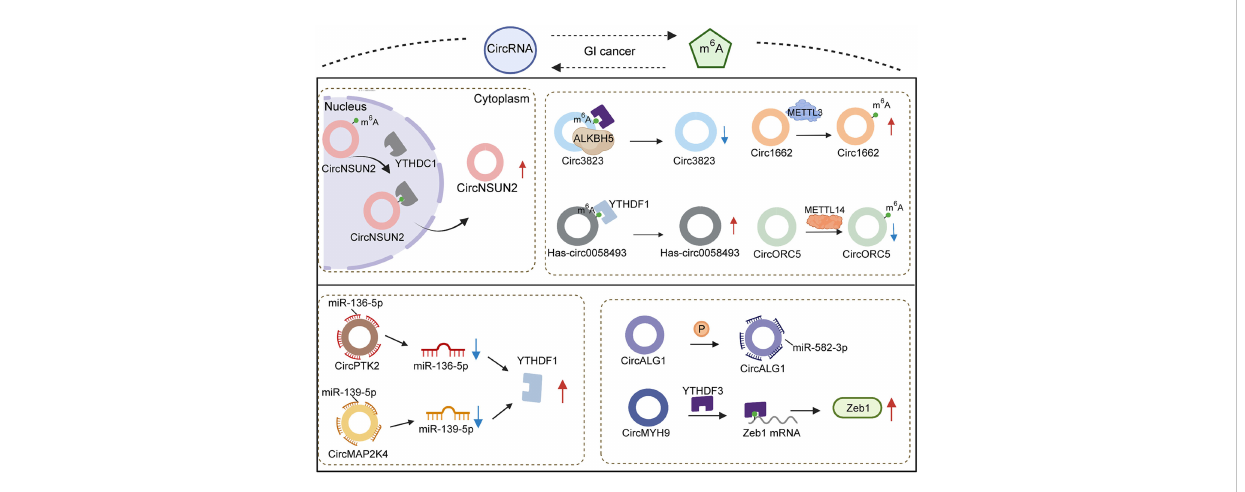
FIGURE 3 Association of circRNAs and m6A regulators in gastrointestinal